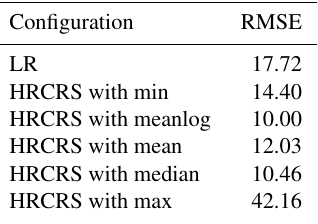
Table 2. RMSE with the HR solution after 1 year of simulation. Table 3. RMSE with the HR solution after 1 year of